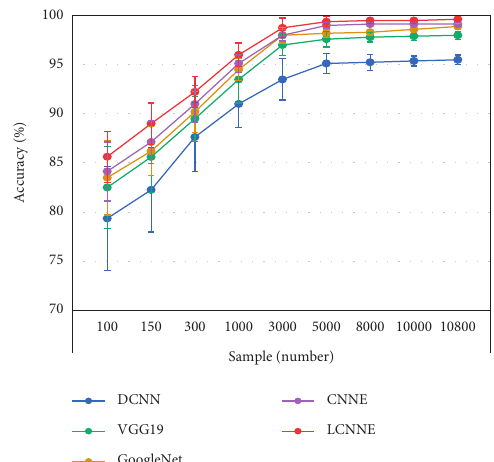
Figure 8: Fault diagnosis results of abrasive grains by different models under different numbers of training